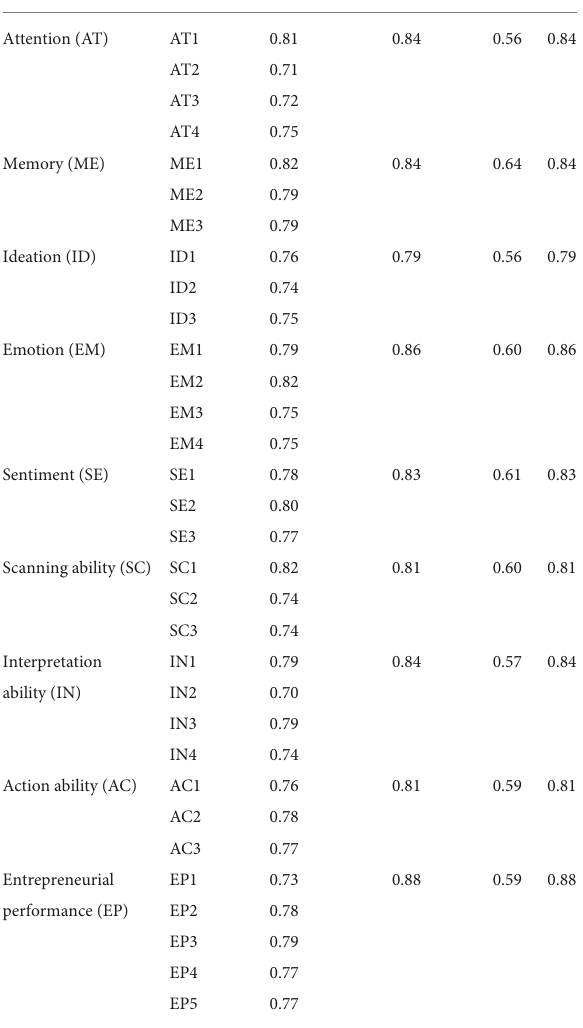
TABLE 1 Test results of reliability and validity of